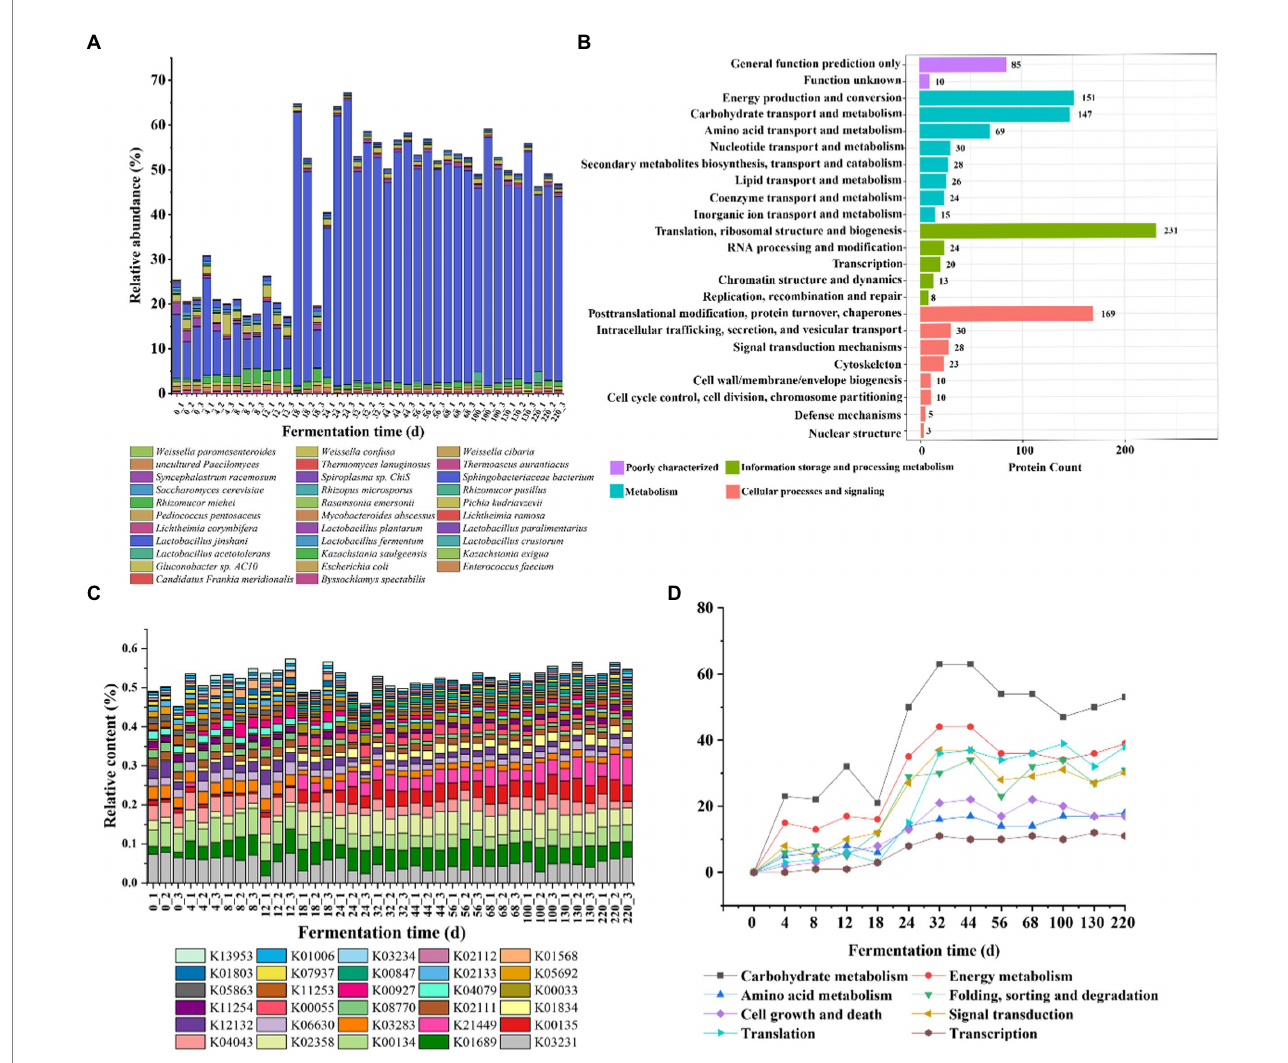
FIGURE 5 Species composition and functional annotation in Jiupei during fermentation process. (A) Microbial composition in Jiupei during fermentation process. (B) KOG function annotated histogram. (C) KO community structure function annotation. (D) Changes in the number of major pathways during